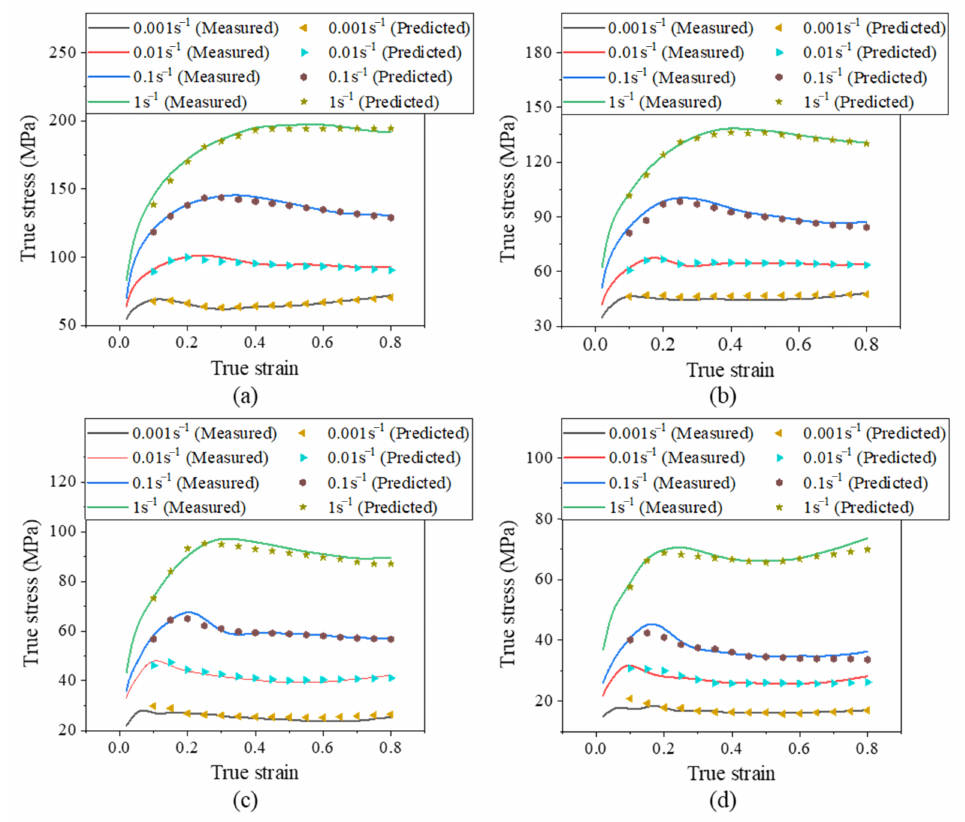
Figure 8. Experimental and predicted flow stress curves using the ANN model for ( a ) 900, ( b ) 1000,